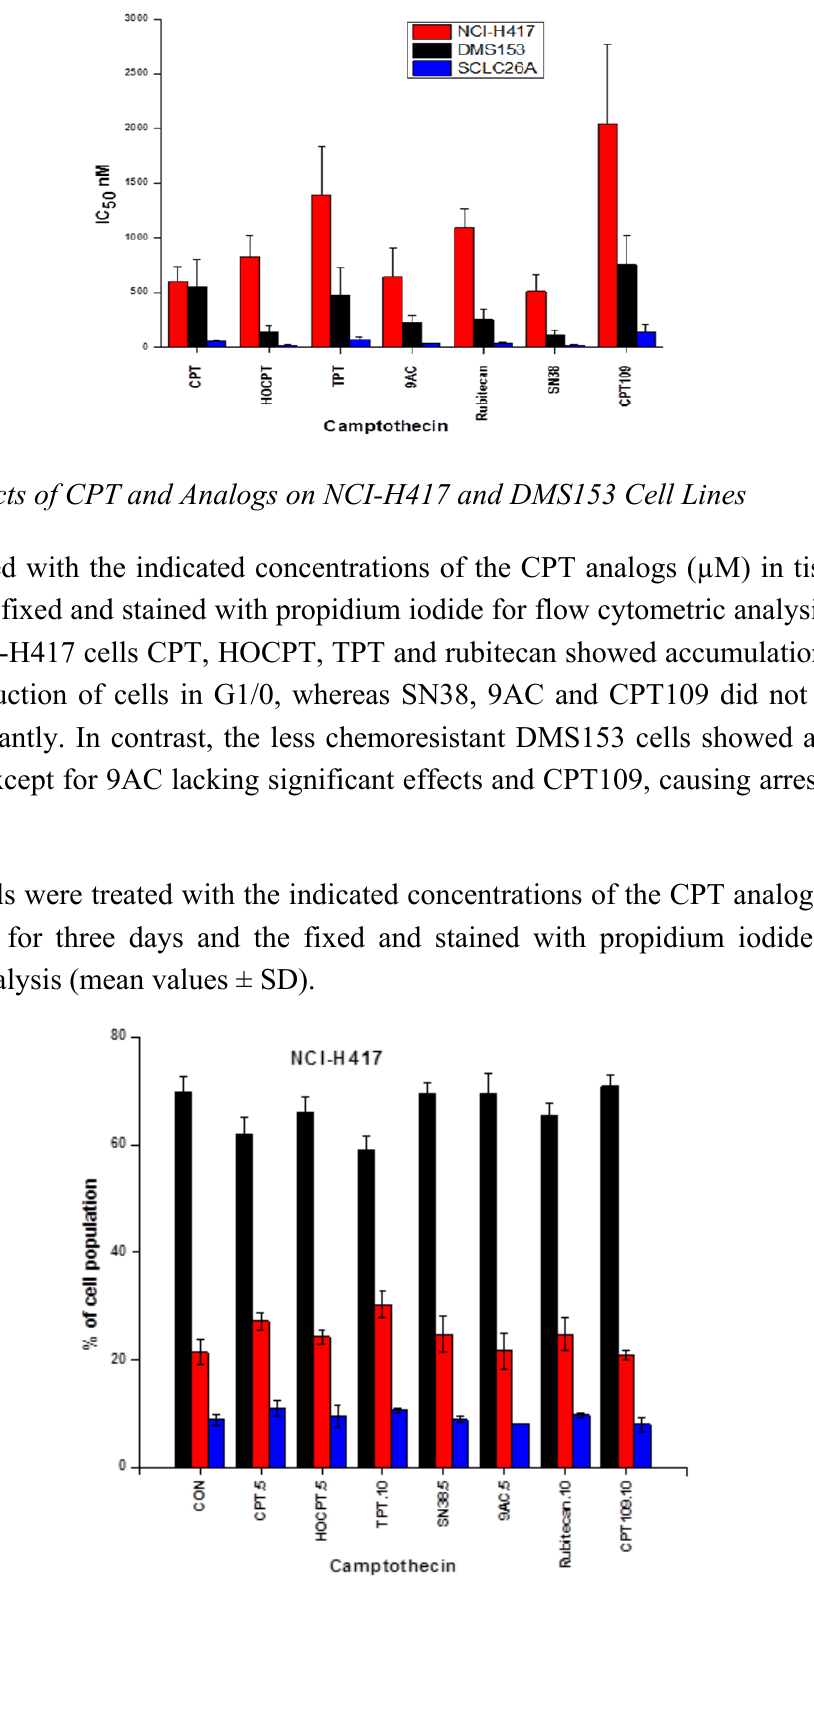
values are presented as 50